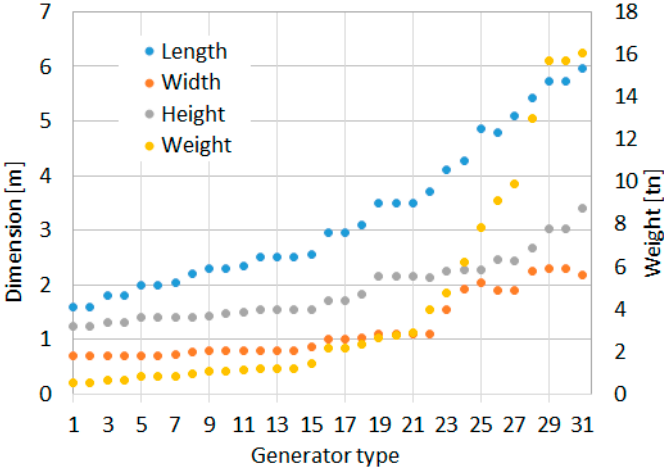
Figure 9. Dimensions and weight.